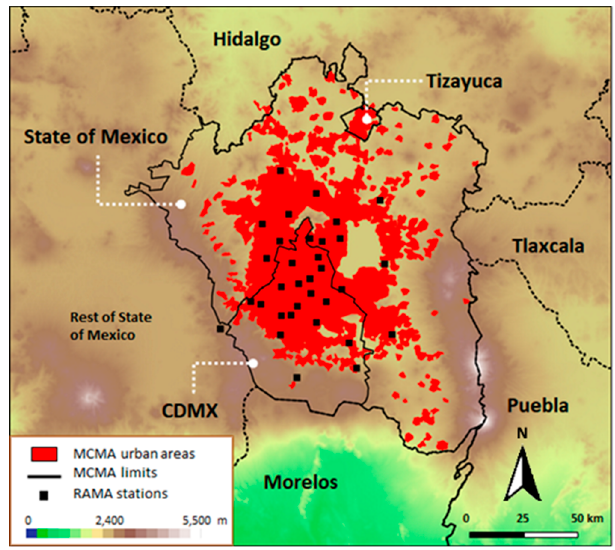
Figure 1. Mexico City Metropolitan Area in 2016. The black squares refer to the automatic air quality monitoring stations (RAMA). The background color scheme represents the elevation above sea level.